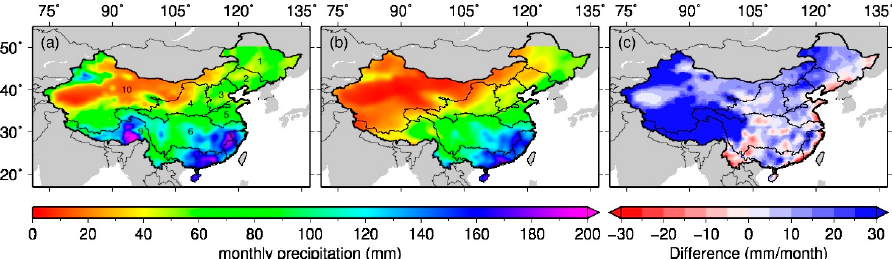
Figure 2. Monthly mean precipitation from ( a ) the raw satellite-based 3B42RTV7 data and ( b ) the gauge-based CN05.1 data, as well as ( c ) the difference between the two products over the overlapping period (2001–2016). (1–10) the basins/regions shown in Figure 1.